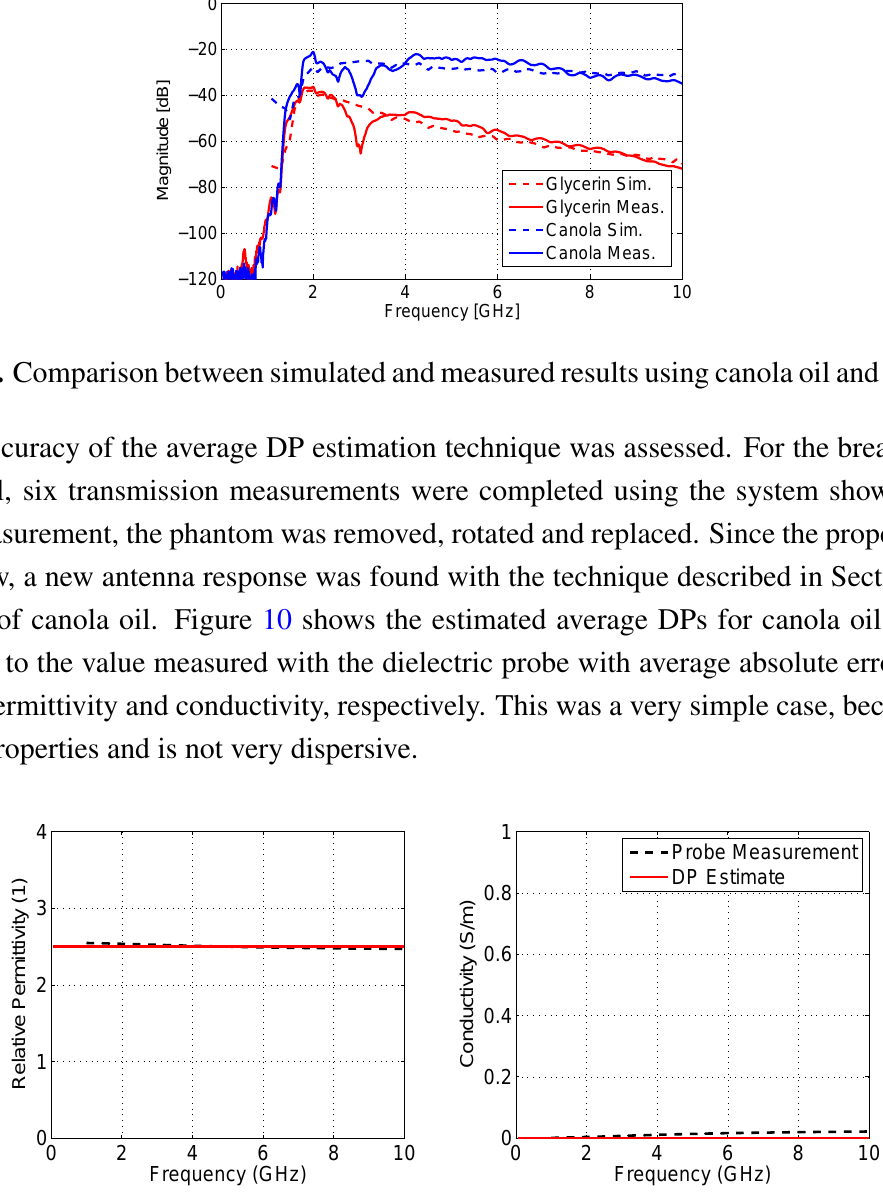
Figure 10. Estimated average DPs for canola oil using the measured